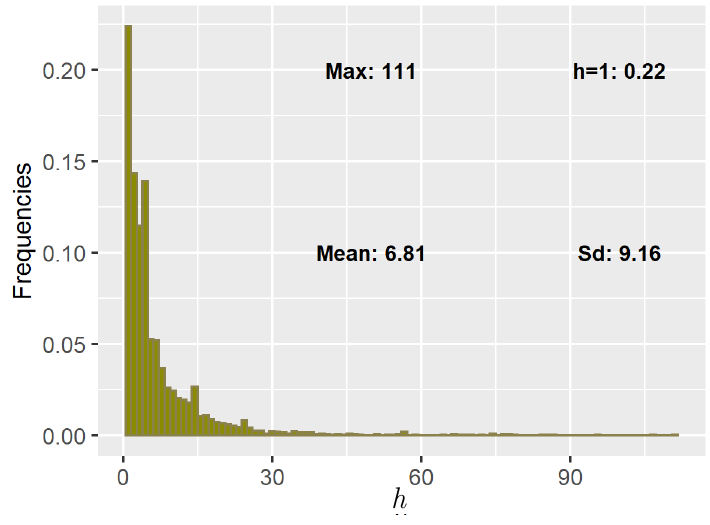
Figure 5. Plot of the empirical h frequency histogram for the Trapani station over the whole year. 111 is the maximum registered depth. The mode is h = 1 with relative frequency 0.22. The mean and the standard deviation are 6.81 and 9.16 respectively.